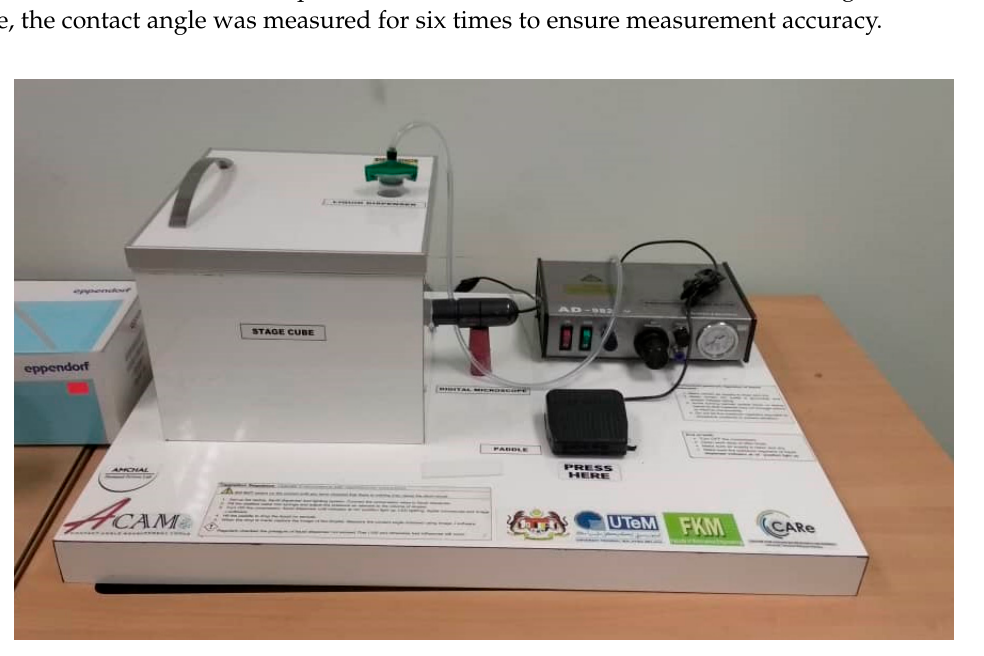
Figure 3. Contact angle measurement equipment.